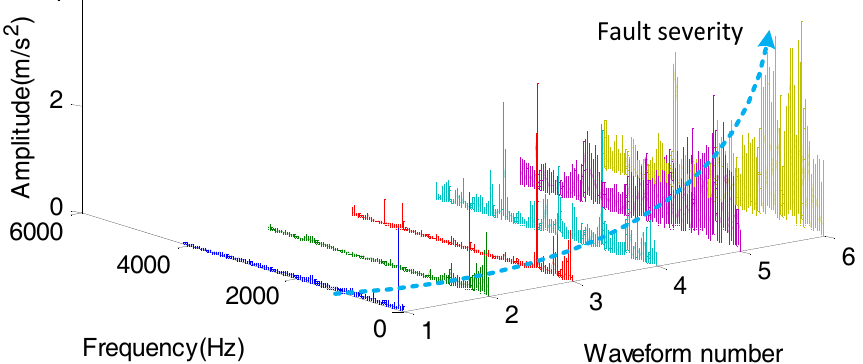
Figure 2. The amplitude spectrums with different fault levels.